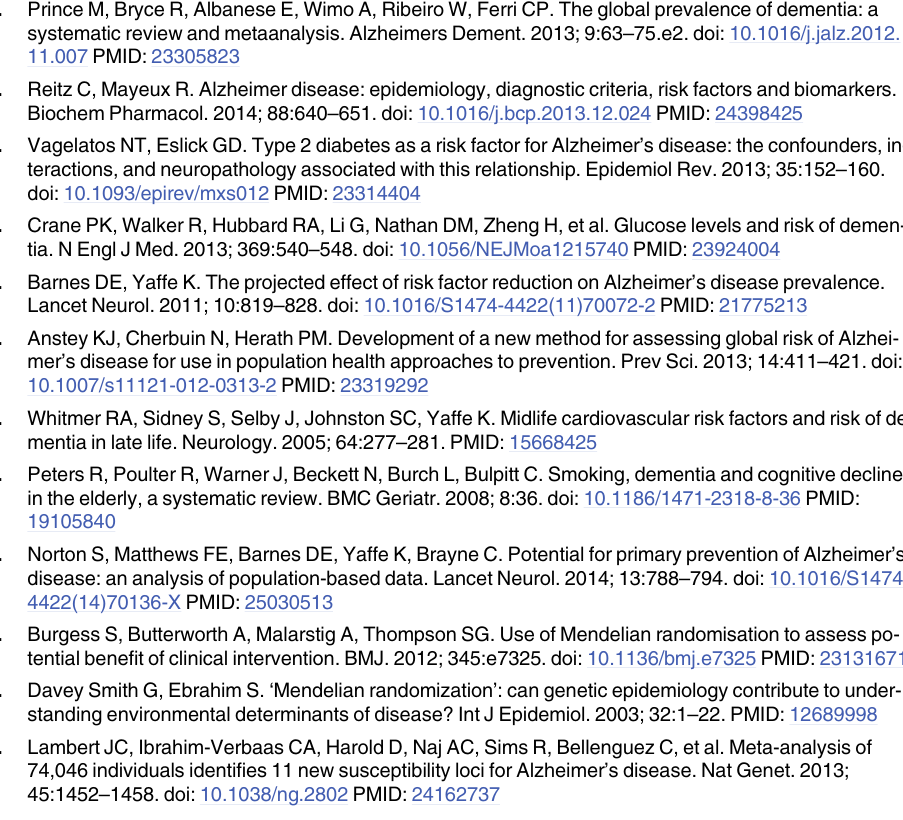
S1 Table. SNPs associated with putative Alzheimer disease risk factors. SNPs included in each risk score, their associations estimated by the relevant consortium, and their association with AD (IGAP [12]). Proxies are marked by an asterix in the leftmost column. The effect allele frequency was based on data from the EPIC-InterAct study [26]. Double asterisks indicate that frequency information was not available in the EPIC-InterAct study, and were obtained from European 1000 Genomes